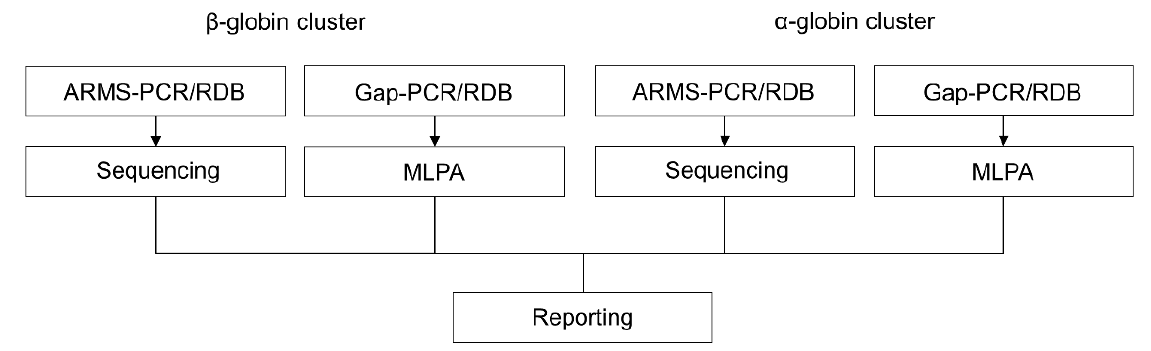
Figure 1. Comprehensive conventional PCR-based genotyping. ARMS-PCR and gap-PCR detect common SNV/indel and CNV, respectively, while the reverse dot-blot (RDB) can be customized to detect SNV/indel and CNV simultaneously. Sequencing and MLPA genotype unknown SNV/indel and CNV, respectively.